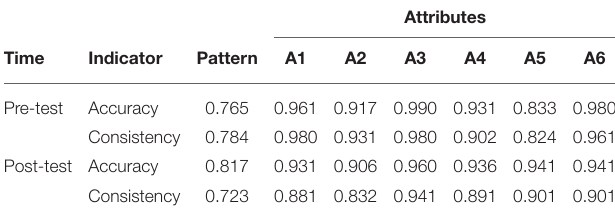
TABLE 6 | Classification accuracy and